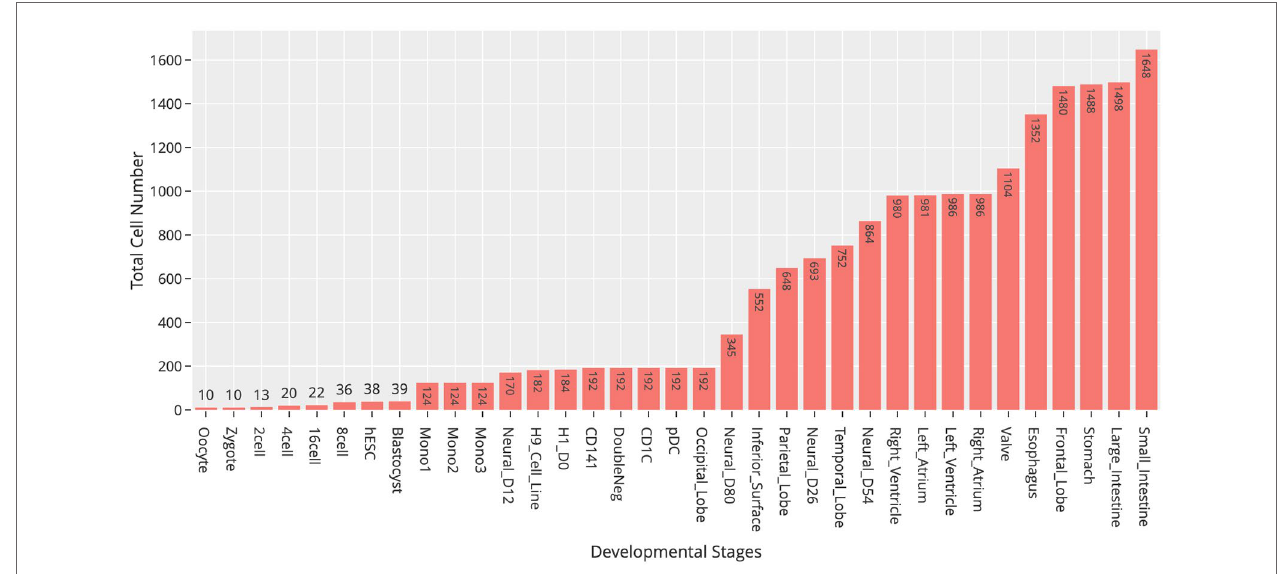
FIGURE 2 | Statistics of cell numbers of 35 developmental stages.